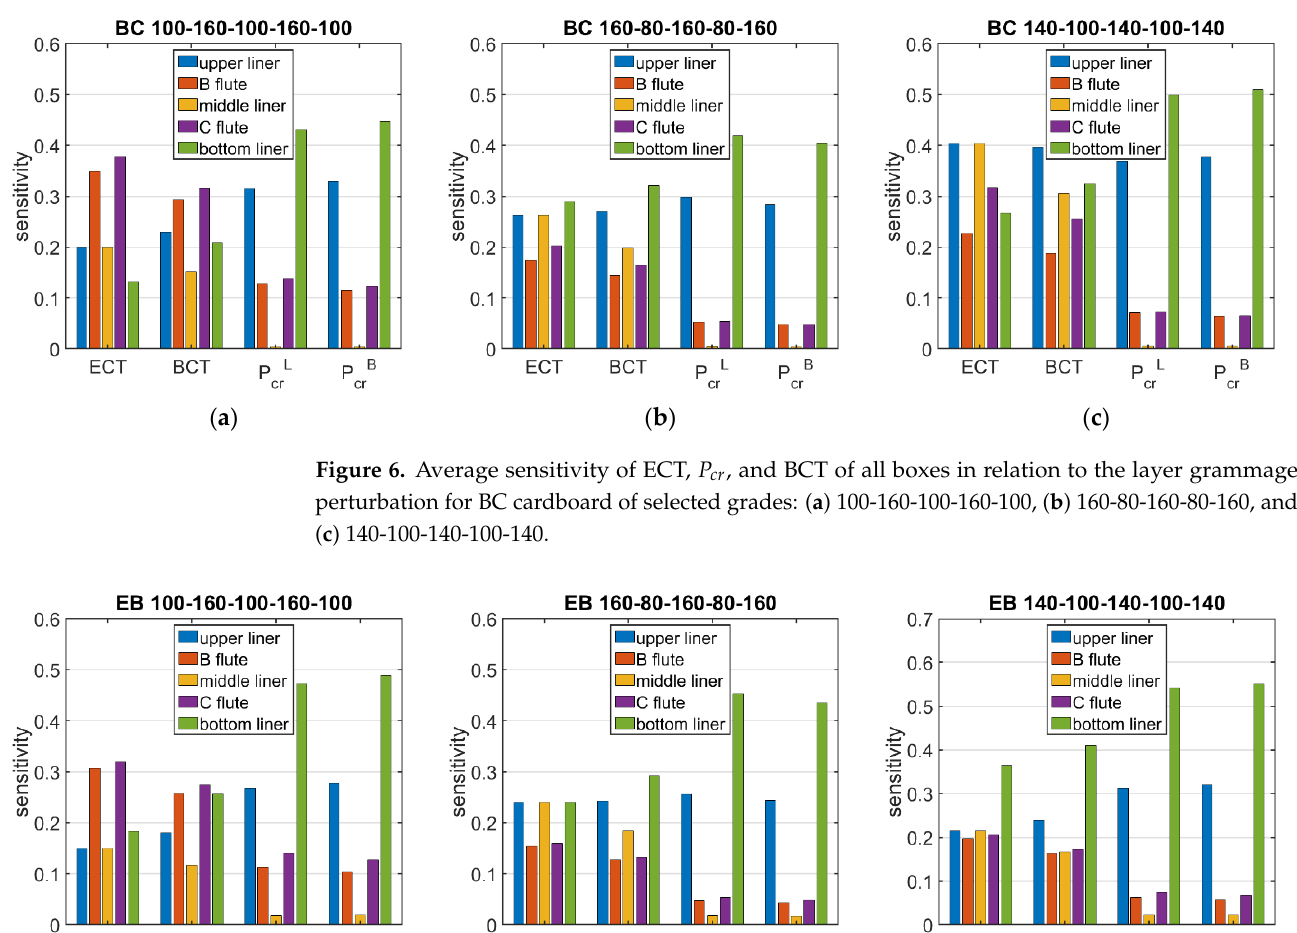
( d ) Figure 5. Sensitivity of ECT in relation to the layer grammage perturbation (1–bottom liner, 2–higher flute, 3–middle liner, 4–lower flute, 5–upper liner) for: ( a ) BC, ( b ) EB, ( c ) EC, and ( d ) EE corrugated cardboard. Figures 6 and 7 show the sensitivities of ECT, 𝑃 (cid:3030)(cid:3045) , and BCT with respect to the gram- mage of the cardboard layers. The presented results are average values that were obtained from 120 boxes of various dimensions. The dimensions of the box base were from 100 ×